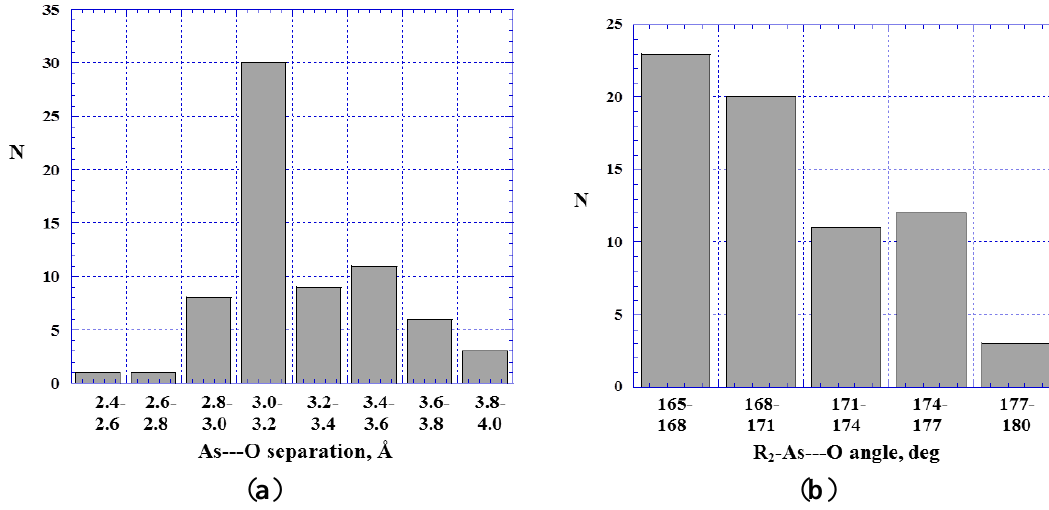
Figure 6. Histograms showing numbers N of R separations ( a ) and R –As---O angles ( b ). 2